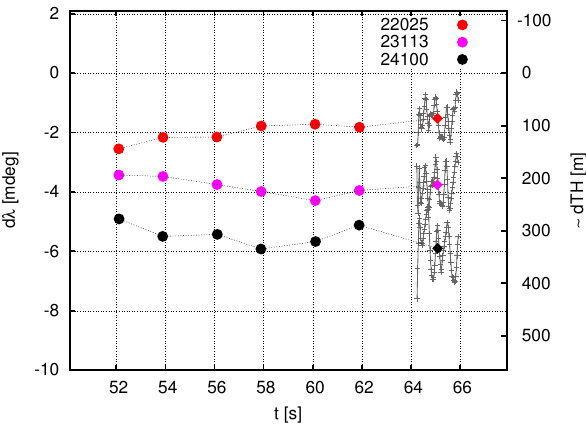
Fig. 11. Examples for the EAOs retrieved for state 47 (orbits 22025, 23113, and 24100). The points at 60 and 62s are the fits from the last up- and down-scan. The crosses are the EAOs of the individual readouts, when the SFD directs the mirrors. The oscillations of the control loop are clearly visible. The point at 65s is the mean of the individual SFD